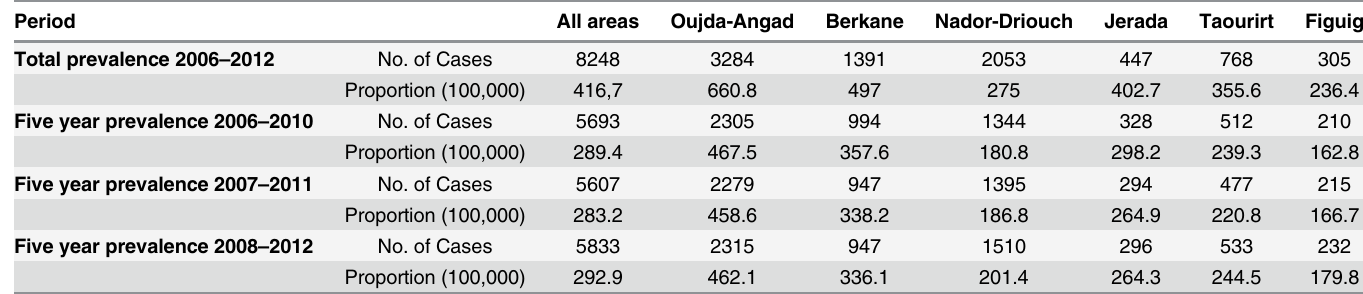
Table 2. Total and five-year prevalence proportions by area of Eastern Morocco.